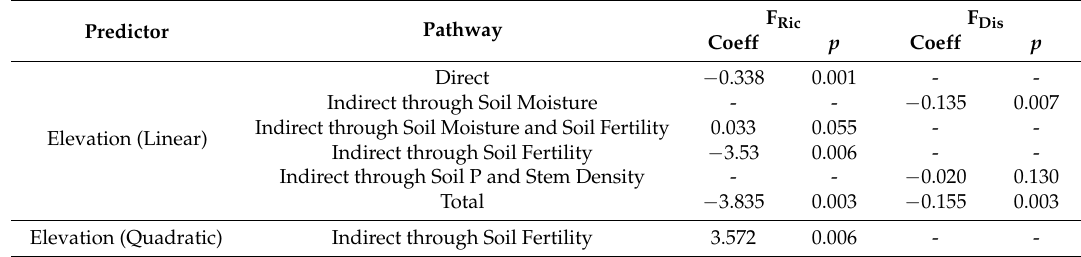
community ‐ weighted mean; WD: wood density; SLA: specific leaf area; Leaf N: leaf nitrogen content; Max. Ht.: maximum height. Table 2. Direct, indirect, and total path coefficients (standardized) of path models containing overall functional diversity measures: functional richness (F Ric ) and functional dispersion (F Dis ). Soil fertility is a principle components analysis (PCA) axis representing soil pH, Base Cation Saturation, and available Ca, Mg, and